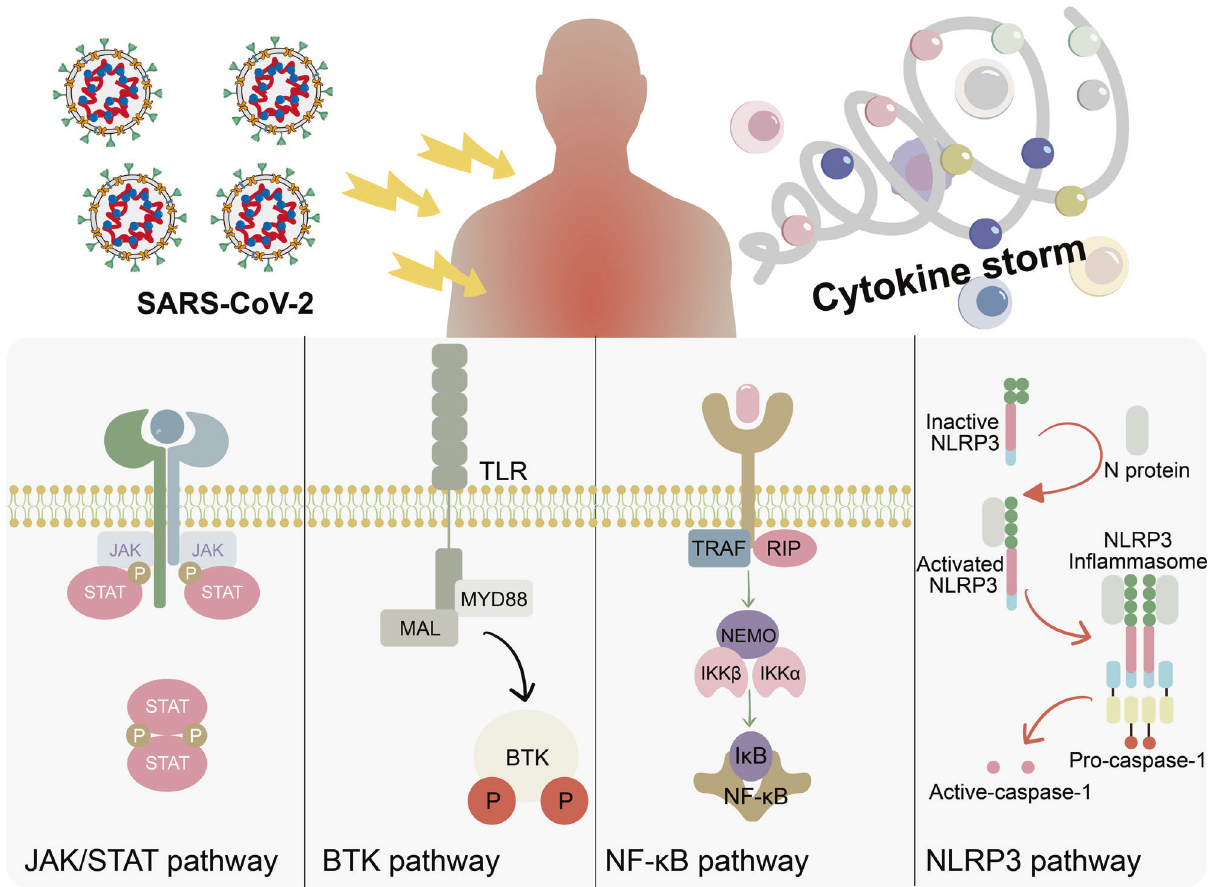
Fig. 7 Illustration of SARS-CoV-2-induced immune responses and pro-in fl ammatory signaling